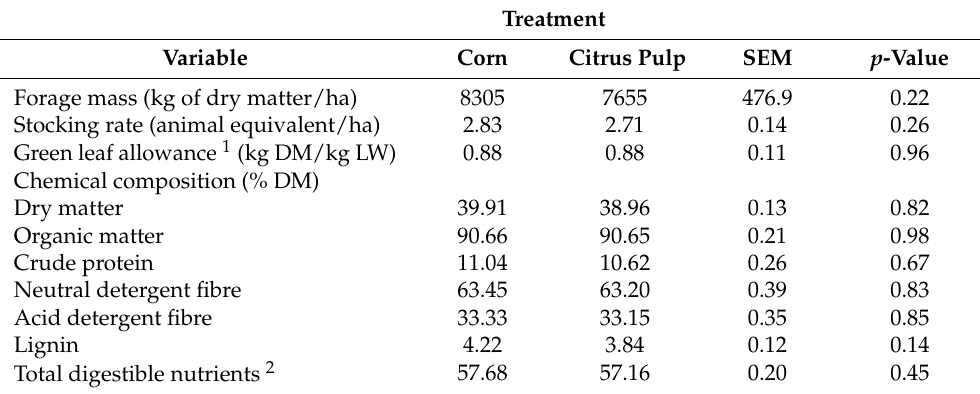
Table 2. Forage mass, stocking rate, green leaf allowance, and chemical composition of pastures in the wet-dry transition period in paddocks of both supplemental treatments.